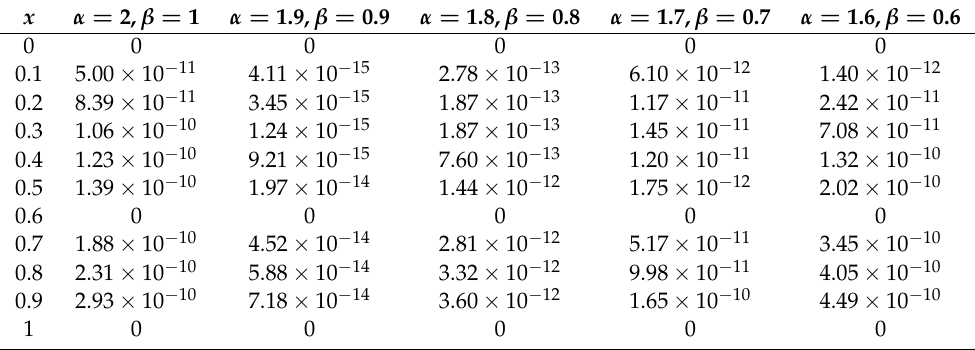
Table 4. Comparison of absolute error of Example 2 for various α , β ( m = 3, n = 8).